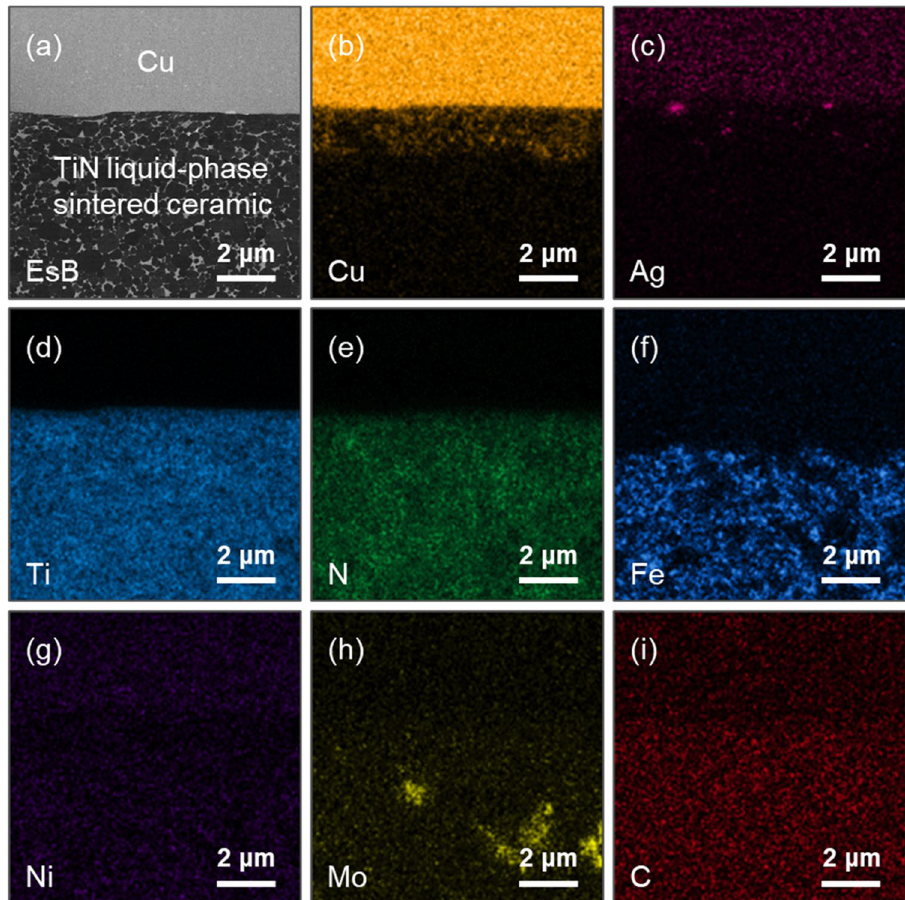
Fig. 4 a Cross-sectional EsB image of the Cu/TiN liquid-phase sintered ceramic interface after bonding for 0.5 h at 850 °C. b – i Elemental distributions of b Cu, c Ag,